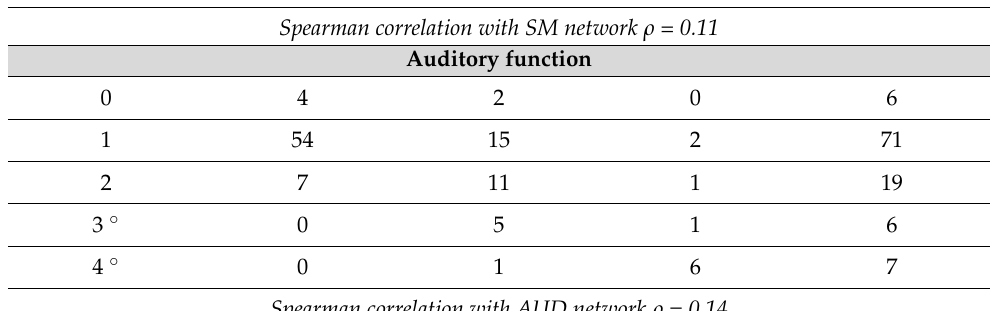
Spearman correlation with SM network ρ =